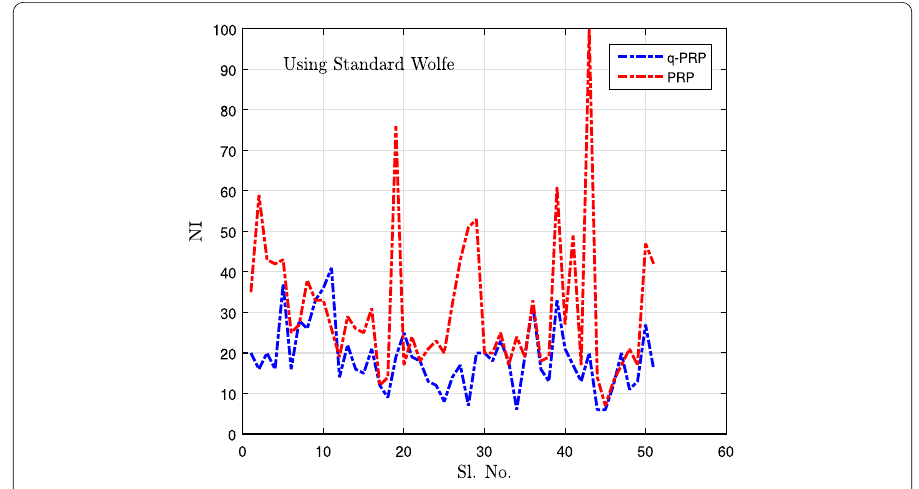
Figure 4 Graphical representation of q -PRP and PRP algorithms under standard Wolfe conditions based on Tables 4 and 5